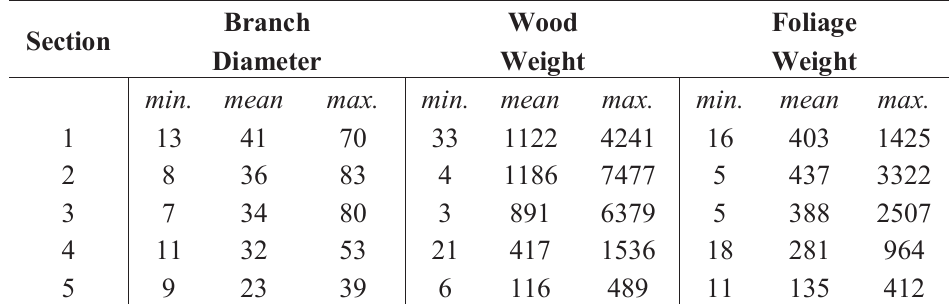
Table 2. Minimum, mean and maximum for branch diameter (mm) and weight (g) by crown position for weight-sampled